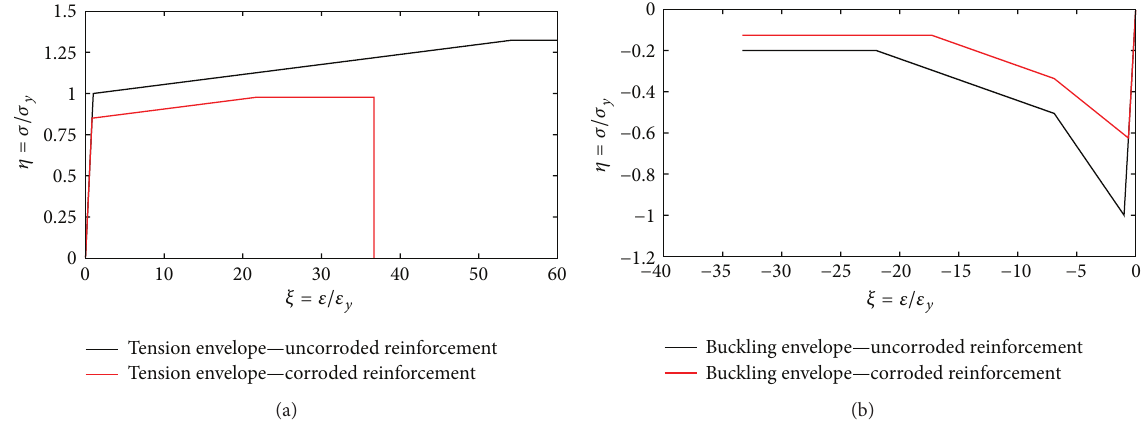
Figure 4: Implemented tension and compression envelopes of corroded bars in OpenSees (20% mass